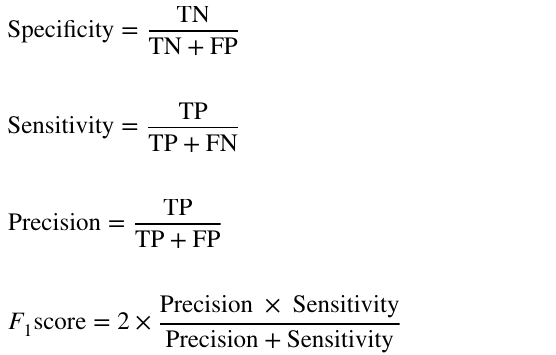
comparison of pre-trained CNN architectures on ZJU dataset